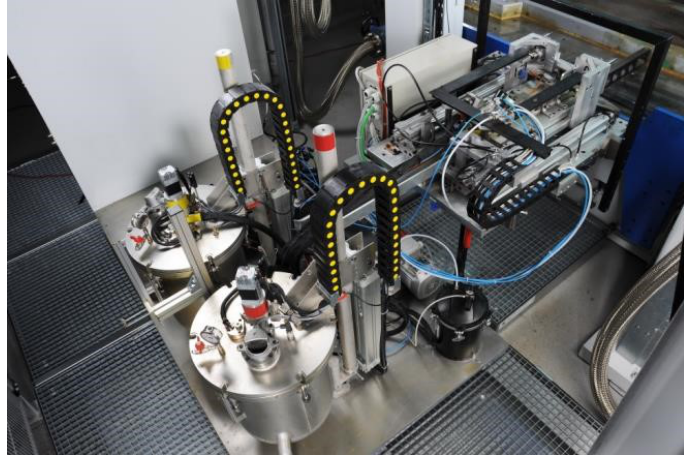
Figure 9: Two-component injection unit with automated docking